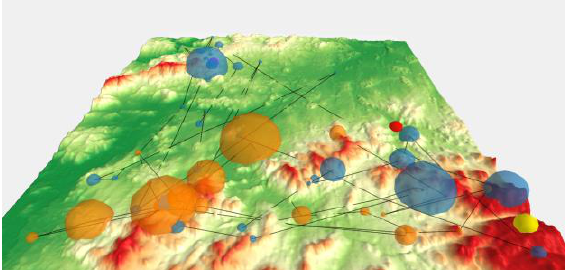
Fig. 8. Scanpath (3D fixations and saccades) of one user for variant A, task 4. Interactive version is available at